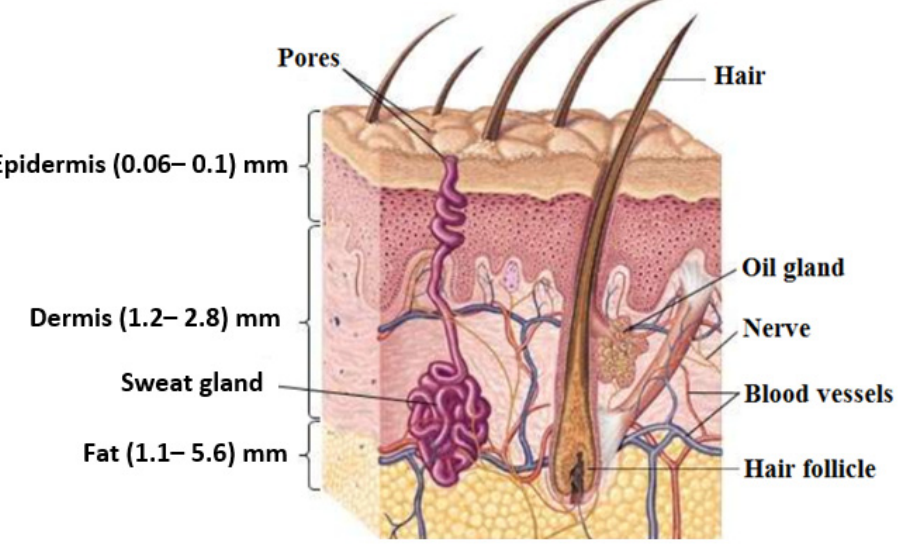
Figure 1. The human skin structure and its derivatives (sweat glands, oil glands, nails, hair, and hair follicles) [15].